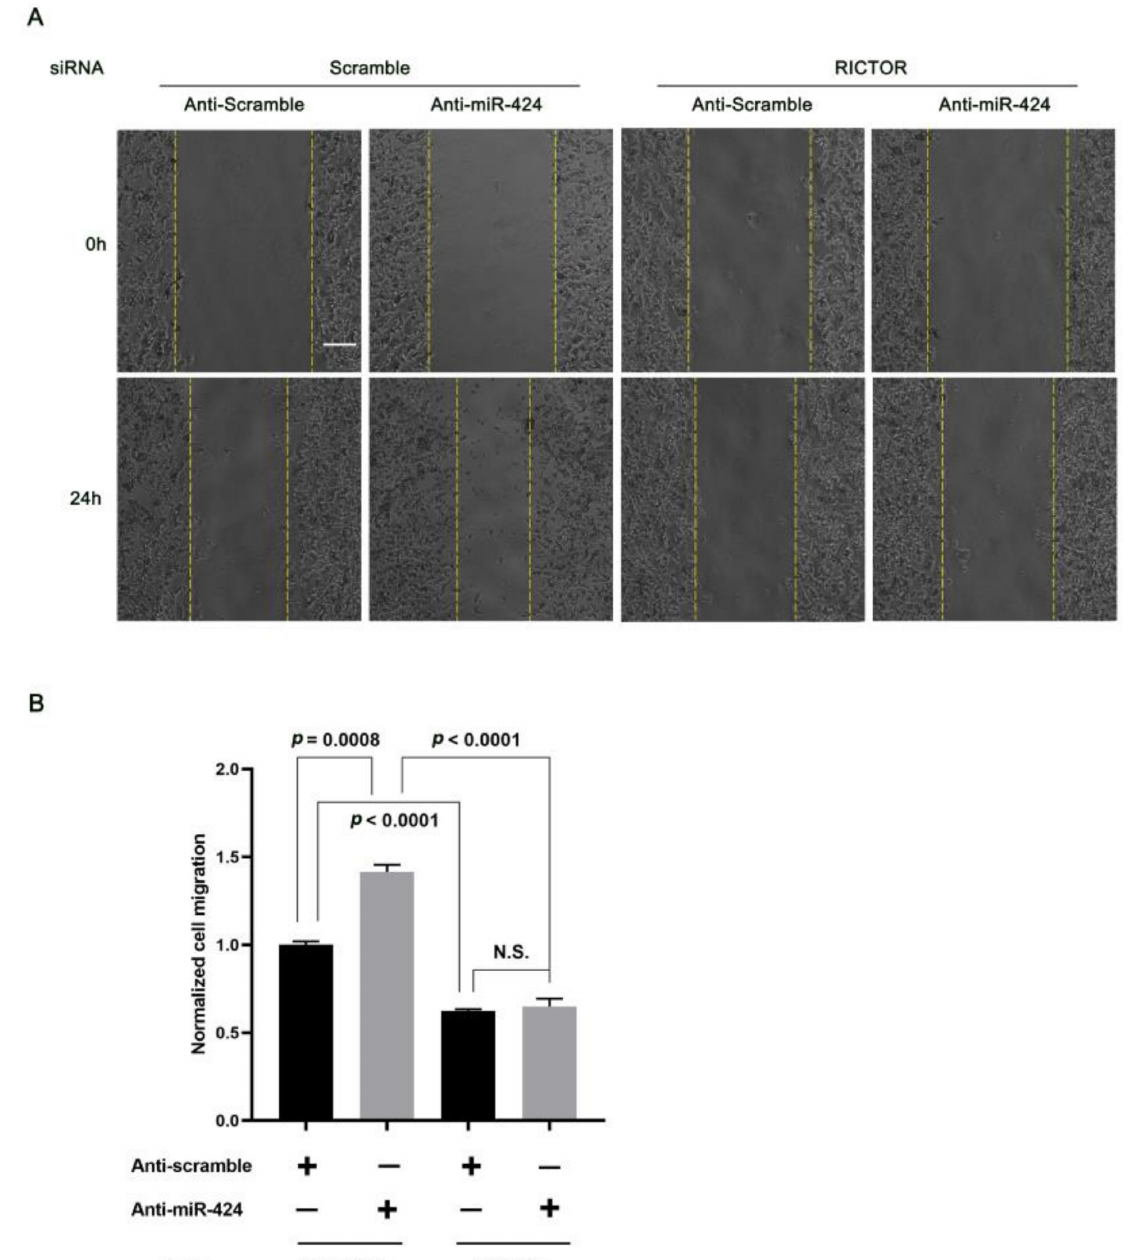
Figure 5. miR-424 regulates the migration of human neural cells in a RICTOR-dependent manner. ( A ) Knock-down of RICTOR rescues the anti-miR-424-induced enhancement in cell migration. SH- SY5Y cells were co-transfected with anti-scramble or anti-miR-424, and control siRNA or siRNA cognate to RICTOR for 72 h. The wound healing assay was carried out as described in Figure 3. Scale bar = 200 µ m. ( B ) Quantification of human neural cell migration. Cell migration was normal- ized to anti-scramble-treated cells. Error bar = SEM (standard error of the mean); N.S., not significant; n =